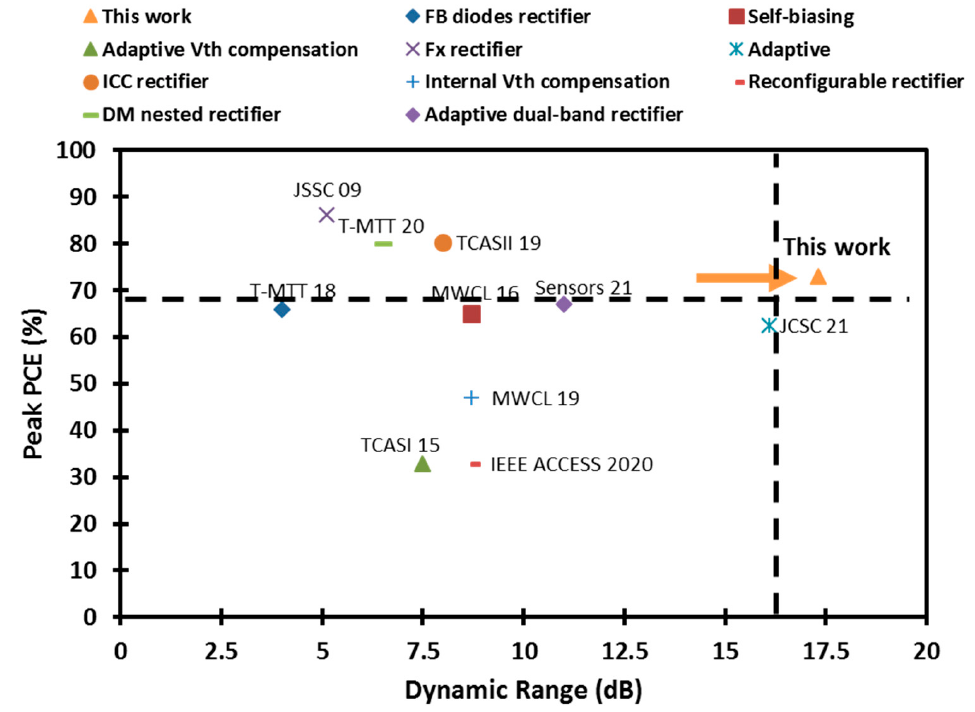
Figure 16. Peak PCE vs. the dynamic range of the published RF CMOS rectifiers at the UHF band.